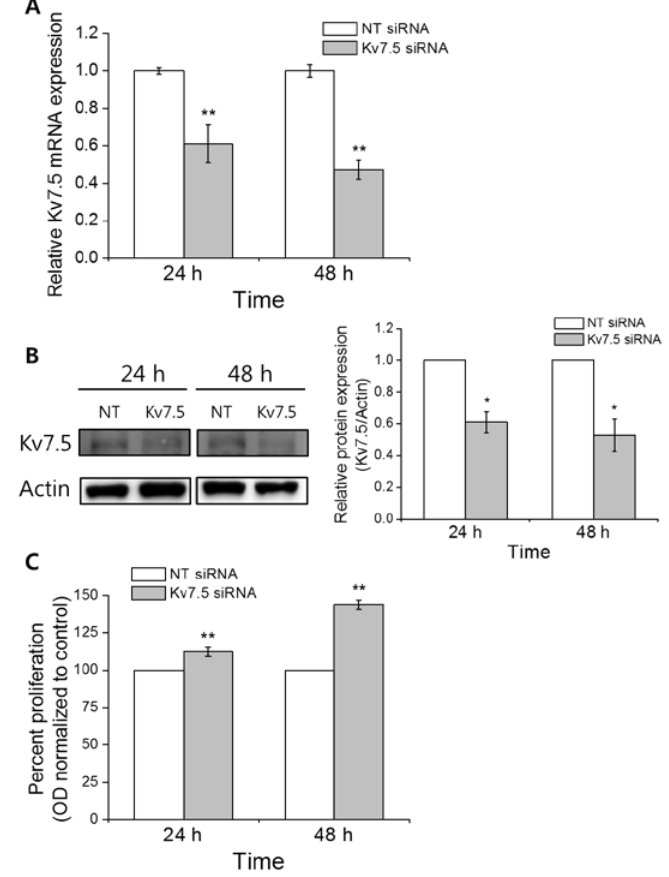
Figure 3. Kv7.5 knockdown by siRNA transfection induces proliferation of CCL-183 cells. The effect of transient knockdown of Kv7.5 in Kv7.5 mRNA ( A ) and protein ( B ) expression in CCL-183 cells was analyzed. The values are the mean ± SEM of four independent transfections; ( C ) An MTT cell proliferation assay was performed on the cells transfected with siRNA, and increased proliferation in Kv7.5-knockdown cells was observed compared to the cells transfected with NT siRNA. The values are the mean ± SEM of 11 independent MTT assays. * p < 0.05; ** p <